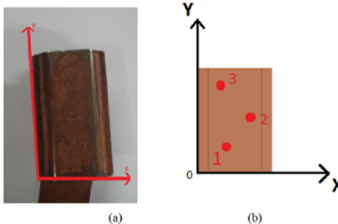
Figure 9. Schematic representation of the measurement points: ( a ) coordinate axis and ( b ) location.